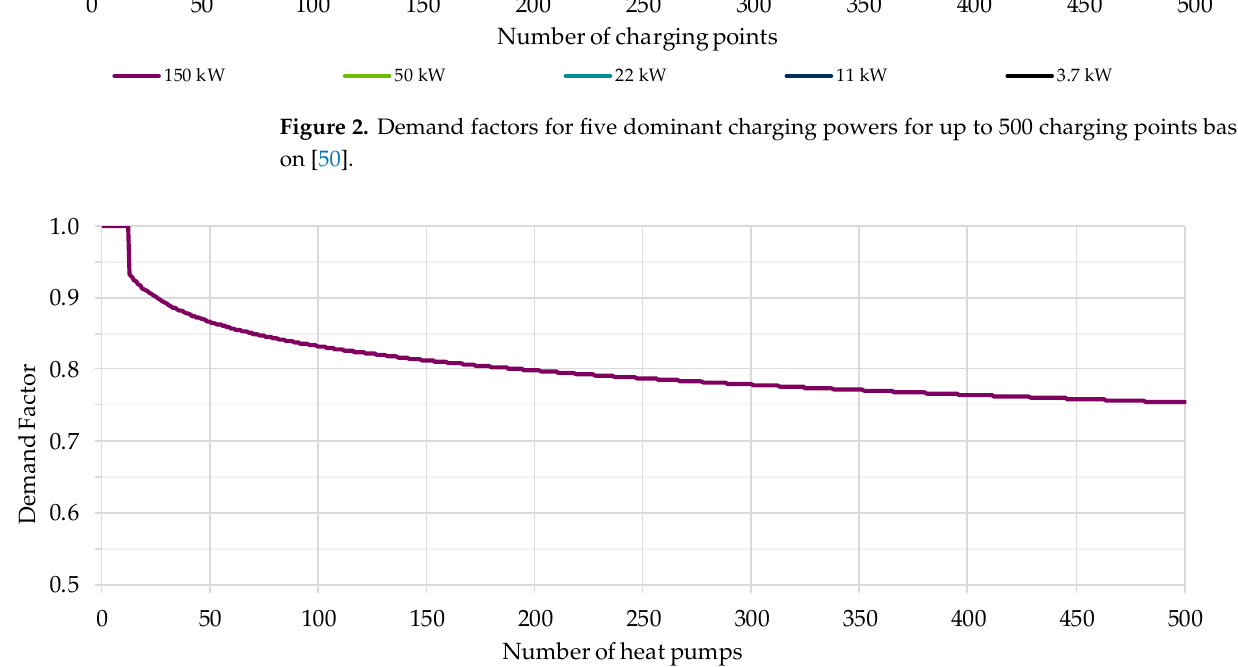
Figure 2. Demand factors for five dominant charging powers for up to 500 charging points based on [50].